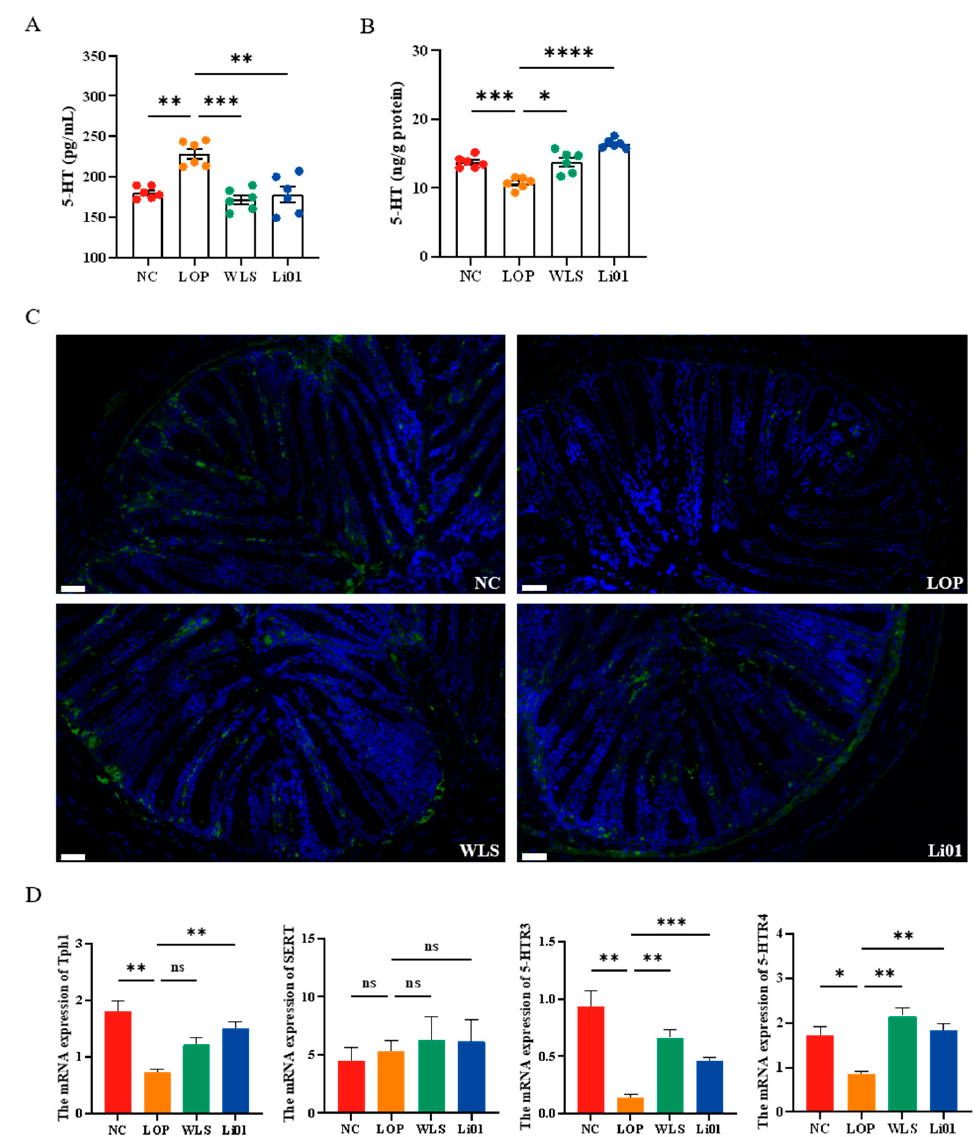
Figure 4. Determination of 5-hydroxytryotamine (5-HT) signaling pathway in mice with loperamide-induced constipation (LOP) after treatment with Ligilactobacillus salivarius Li01 (Li01), Weileshu probiotic (WLS), and the control group (NC). The levels of 5-HT in serum ( A ) and colon tissue ( B ) were measured. ( C ) Representative fluorescent images of 5-HT in colonic tissues. The scale bars represent 30 μ m. ( D ) The mRNA expression levels of Tph1, SERT, 5-HTR3, and 5-HTR4. Data are presented as mean ± SEM, n = 6. Significant differences are denoted by “ns” ( p ≥ 0.05), * ( p < 0.05), ** ( p < 0.01), *** ( p < 0.001), and **** ( p < 0.0001).